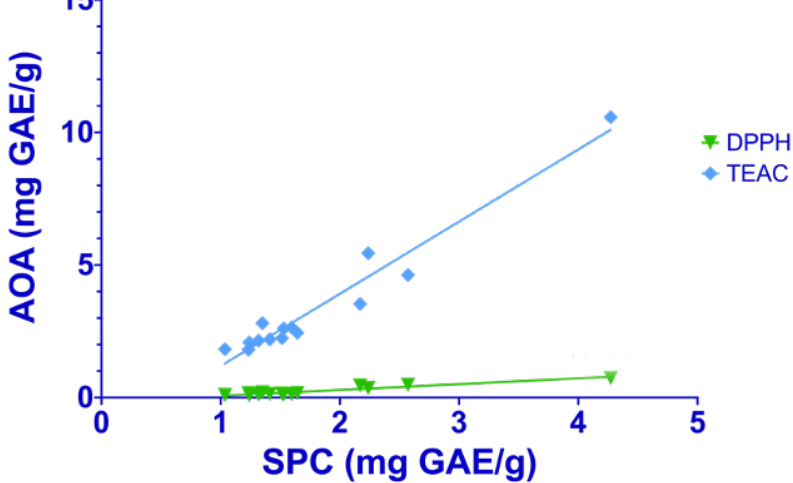
Figure 2. Linear regression between soluble phenolic content (SPC) and the in vitro antioxidant activity (AOA) measured with DPPH (green line) and TEAC assays (blue line) in corn samples.